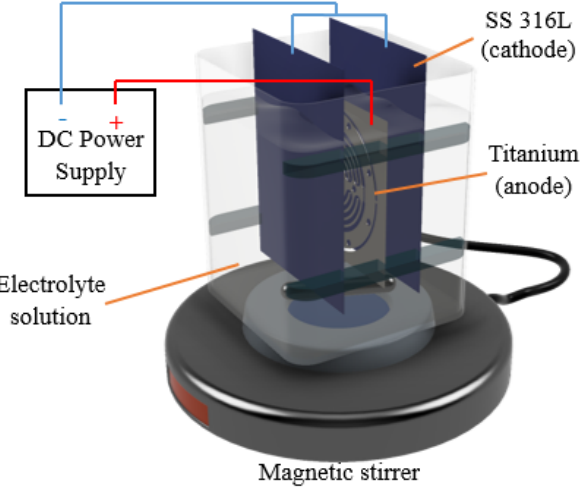
Figure 2. Experimental setup for the EP process. Table 4. Machining parameters ( wire EDM).